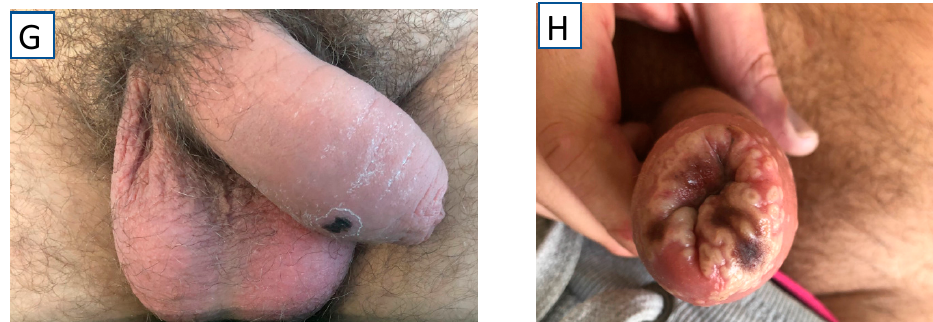
Figure 2. Morphological type of lesions. ( A ) Small pustule (chest); ( B ) Large pustule (leg); ( C ) Papulo-pustule (white center, hand), ( D ) Papulo-pustule (black center, neck); ( E ) Chancriform ulcer (anus); ( F ) Atrophic scar (forehead); ( G ) Necrotic scar (penis); ( H ) Confluent lesions (penis).